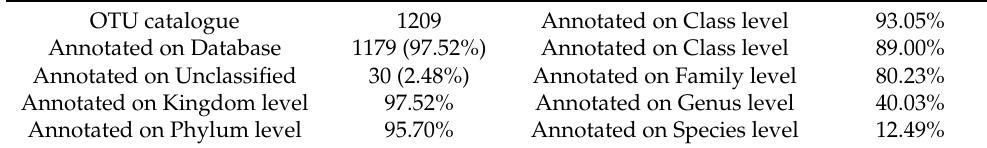
Table 6. Annotated overview of cecal microbial species.